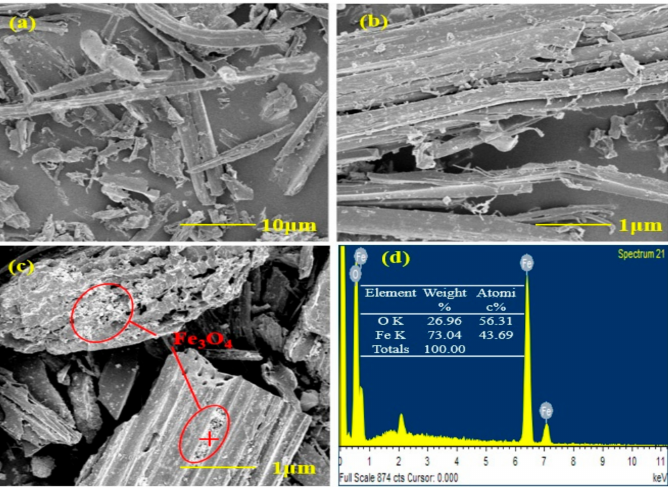
Figure 2. SEM images and EDS spectra of the pristine biochar and m-biochar: ( a , b ) are the SEM images of the pristine biochar; ( c , d ) are the SEM images and EDS spectra of m-biochar.